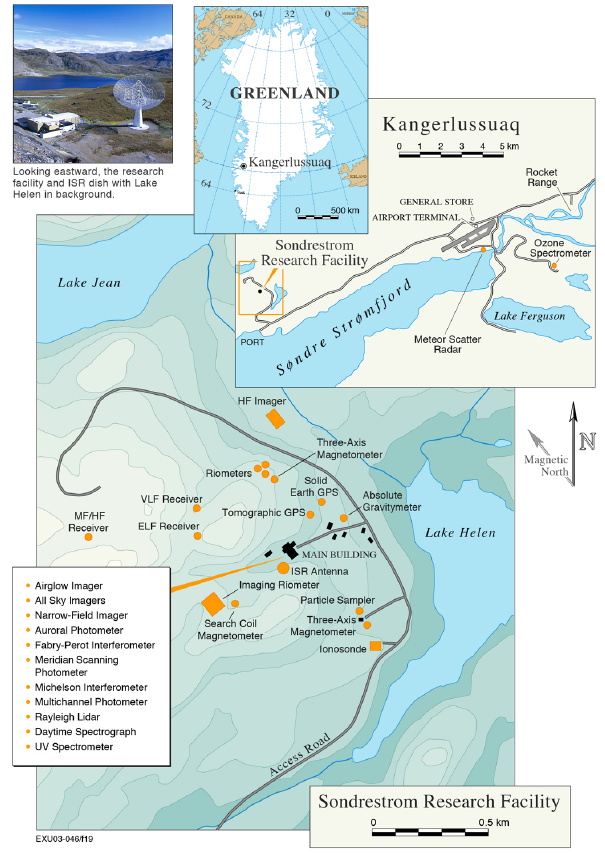
Figure 6. The Sondrestrom Research Facility, located near Kanger- lussuaq, just inside the arctic circle on the west coast of